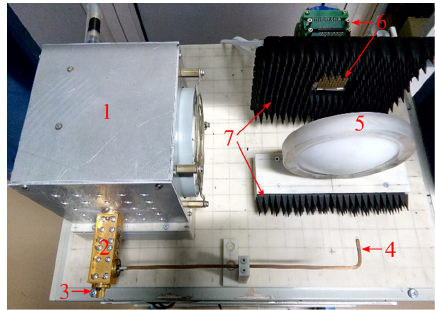
Figure 9. A photograph of the MMW transceiver module. (1) W-band BWO, (2) directional coupler, (3) horn antenna, (4) dielectric rod antenna, (5) dielectric lens, (6) array receiver, and (7) RF absorber. The output power of the BWO is divided into two equal parts with a Dok NO-10/3 directional coupler. The scene is illuminated with a Dok 92–96 GHz Prime Source conical horn antenna, which has a gain of 15 dB and a half-power beamwidth of 30° at the E-plane and 34° at the H-plane.